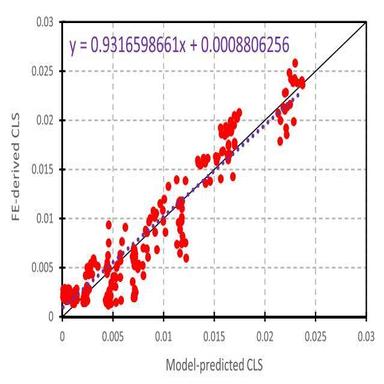
RHT model prediction vs. FEA.